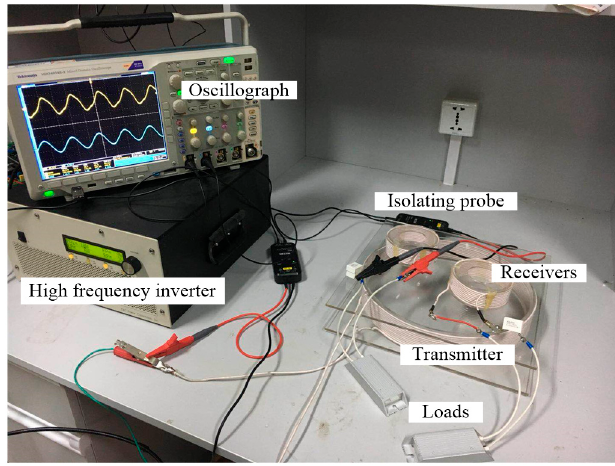
Figure 7. Experimental devices for a multi-load WPT system based on the S–S model.